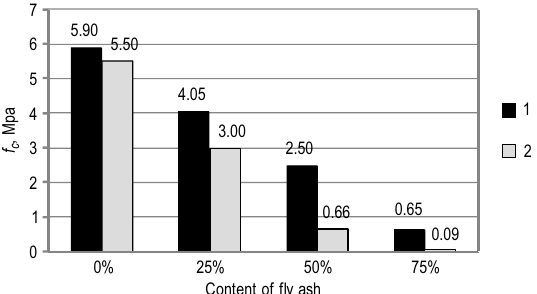
Fig. 5. The dependence of the average values of the compressive strength on the content of fly ash and the type of soil following 7 days of hardening: 1 – sand soil, 2 – clay soil